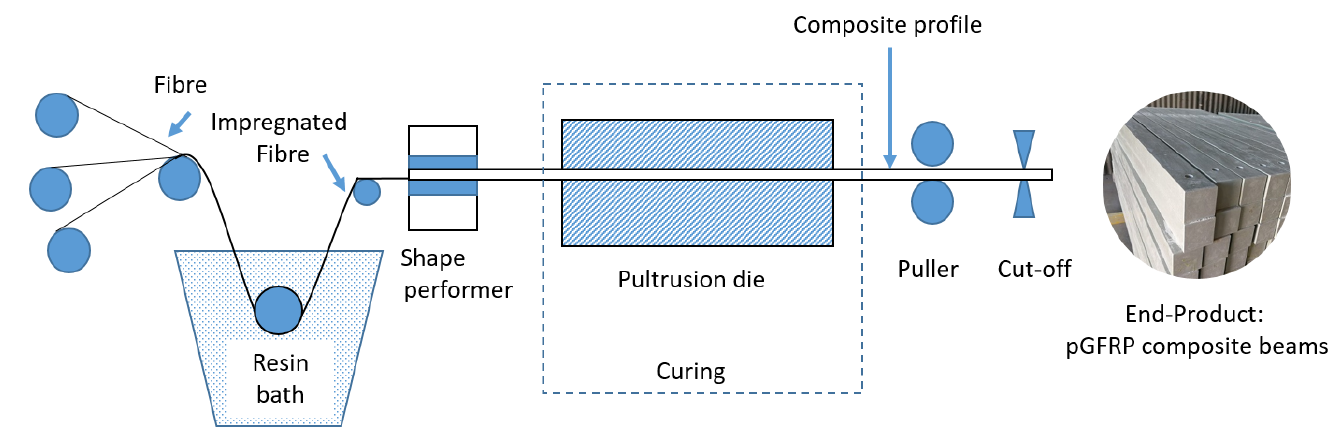
Figure 1. Schematic diagram of pultrusion process of glass fibre/UPE composite beams.